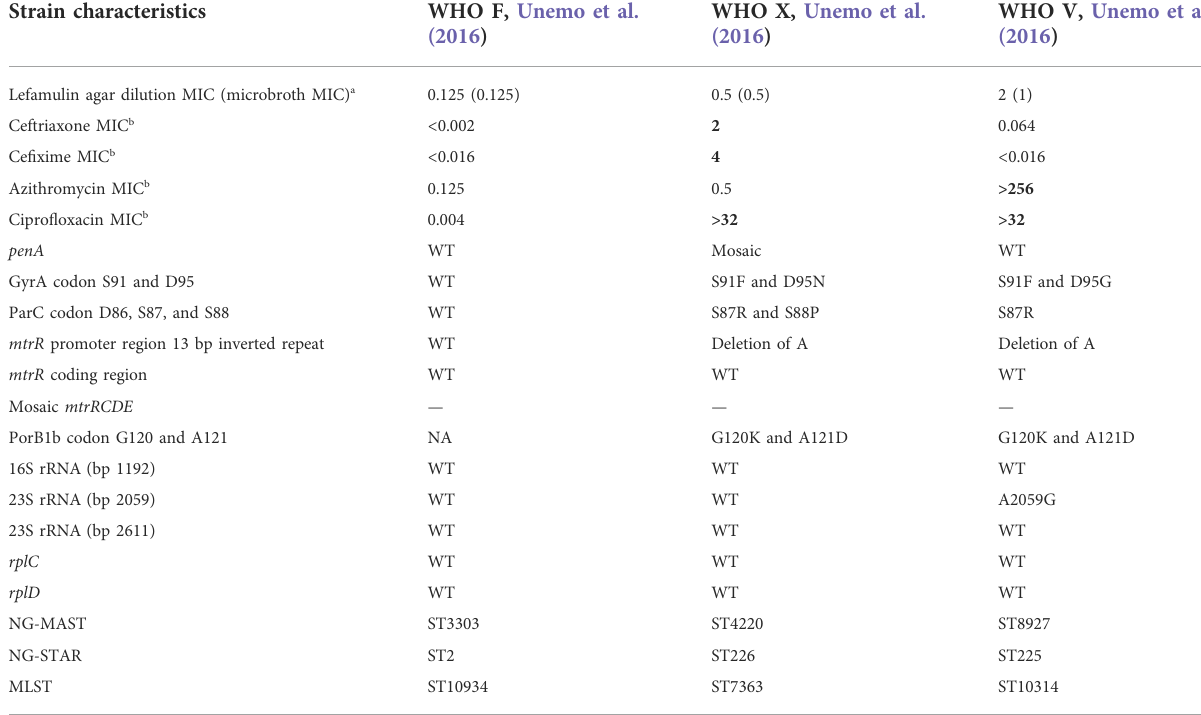
TABLE 1 Relevant phenotypic and genetic characteristics of Neisseria gonorrhoeae strains. Strain